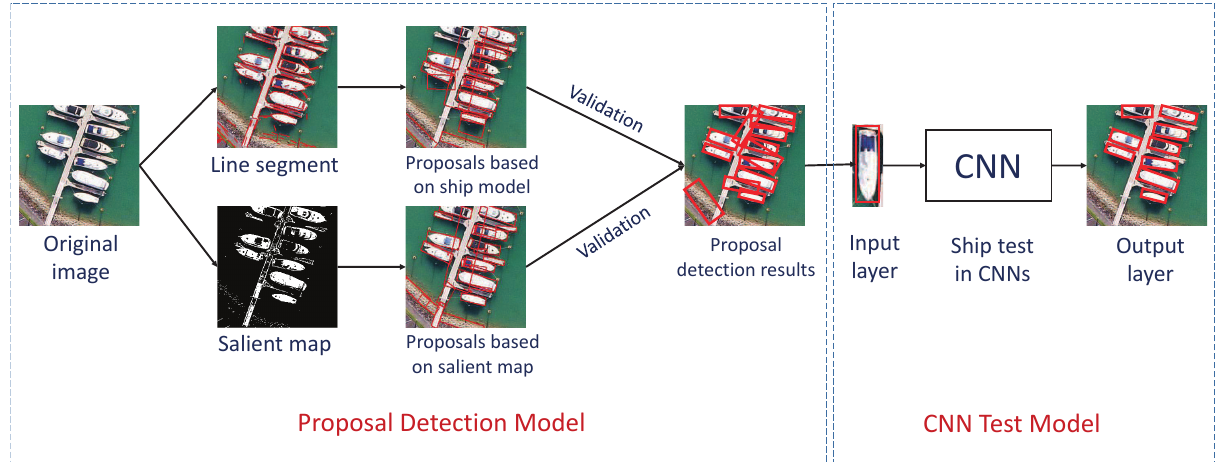
Figure 1: The flowchart of our proposed ship detection